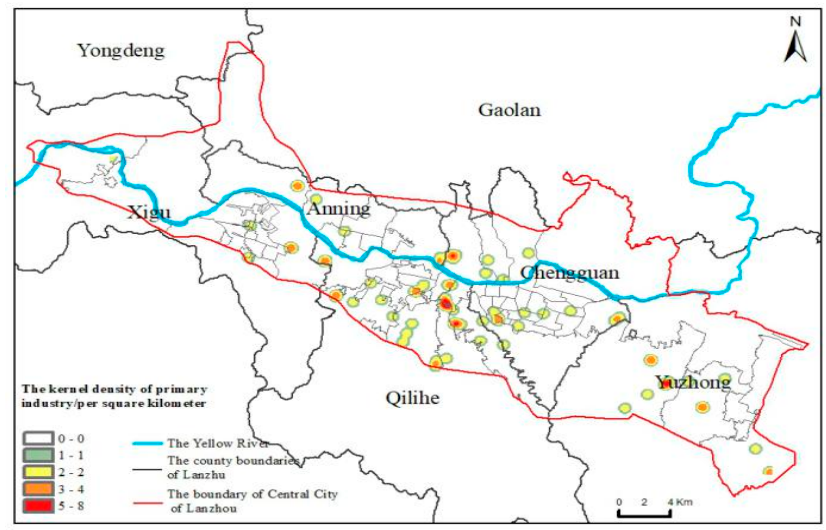
Figure 5. The kernel density distribution of primary industry.